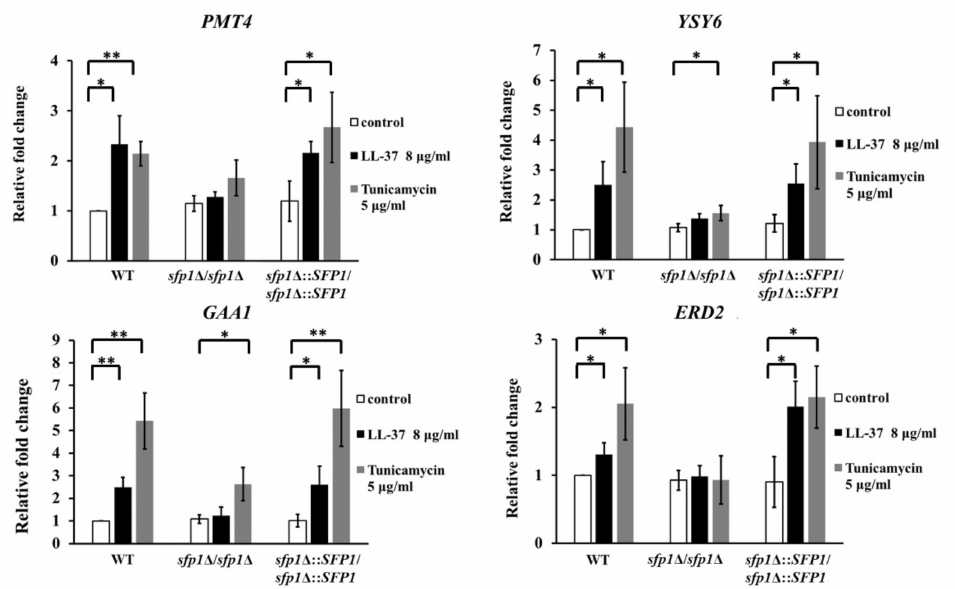
Figure 4. Effect of LL-37 and deletion of SFP1 on the expression of UPR genes. Cells were treated with or without LL-37 or tunicamycin for 30 min. Real-time quantitative PCR was used to detect UPR gene expression. The PMA1 transcripts were used as an endogenous control. The results are expressed as the mean ± SD of three independent assays. * p < 0.05; ** p <